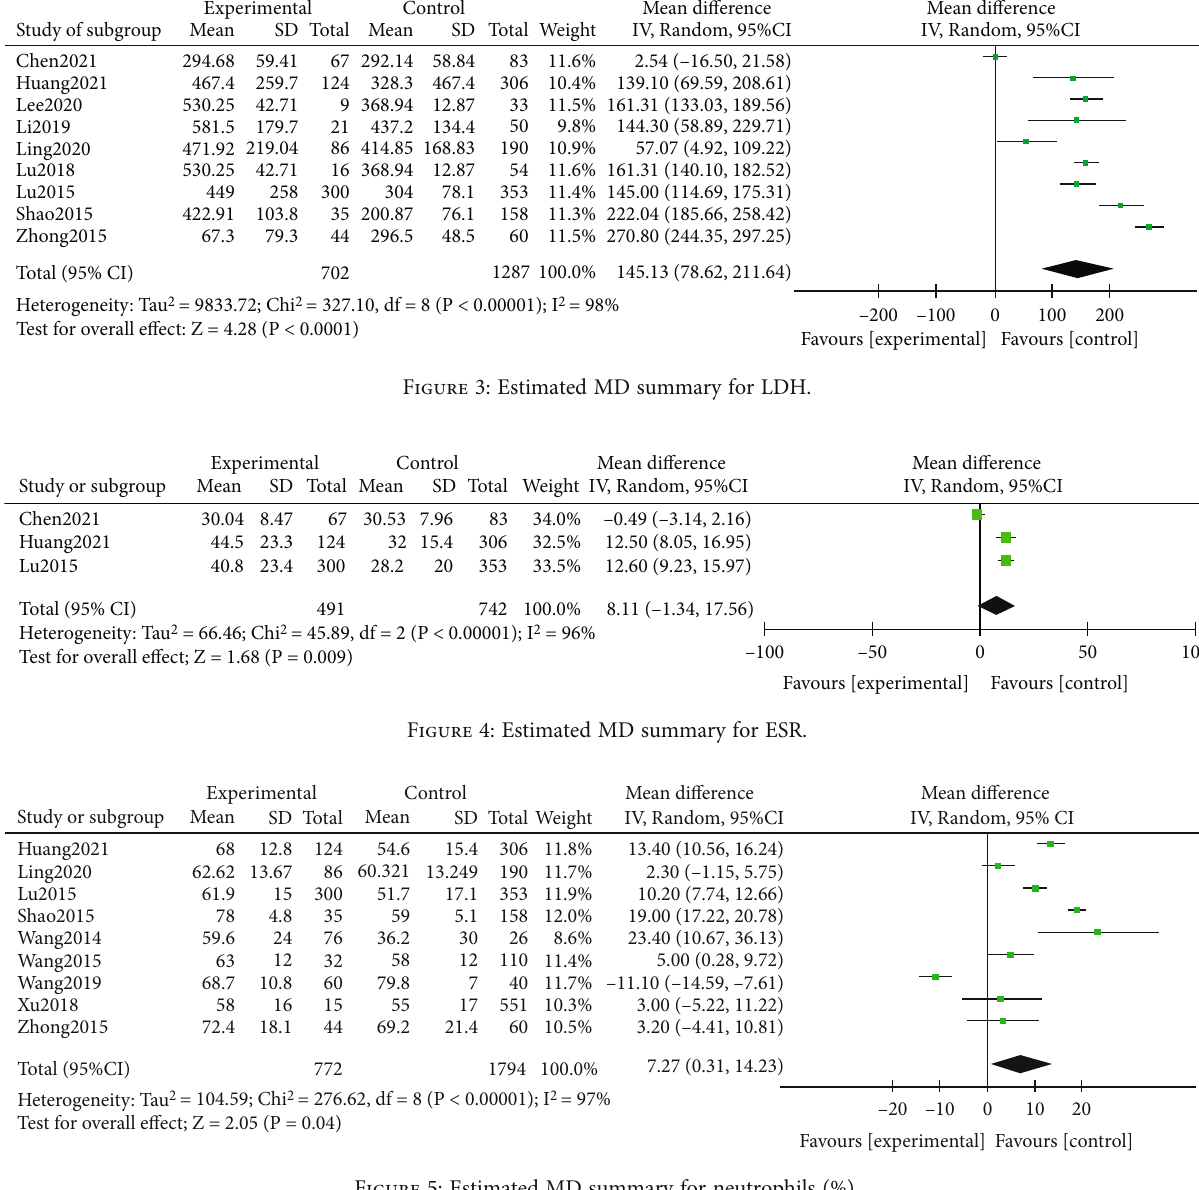
Figure 5: Estimated MD summary for neutrophils